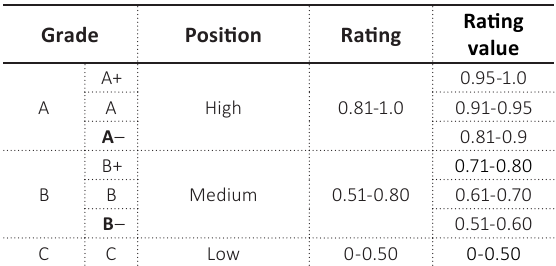
Table 2. Distribution of university rankings